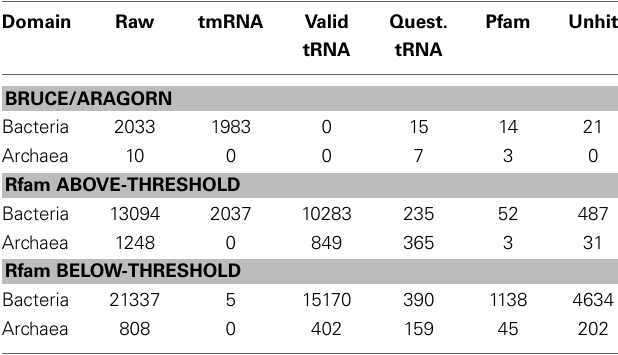
Table 1 | Evaluation of primary tmRNA sequence-finding